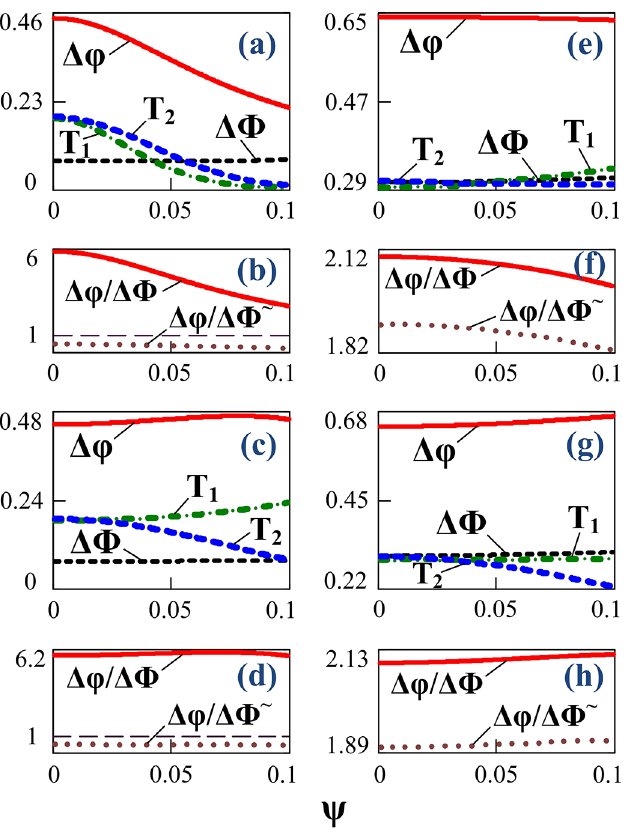
Fig. 8. Dependences of PSD D ’ , DF , relations D ’ / DF , D ’ / DF ∼ and energy transmission coef fi cients T 1,2 of waves 1, 2 on incidence angle c for silver layers 1, 3, two different wavelengths and TM (a, b, e, f), TE (c, d, g, h) polarizations of the incident wave. The values of parameters are: (a – d) l = 292nm, d 1,3 =125 nm, d 2 =19 nm; (e – h) l = 650nm, d 1,3 =9 nm, d 2 = 171nm. Figures b, d, f, h detail the data in fi gures a, c, e, g, respectively. The black horizontal dashed line in fi gures b, d characterizes equality to 1 of the corresponding quantities. Parameter c is used as the abscissa axis for all the graphs. Values of c (as D ’ , DF , DF ∼ ) are given in the relative units of radians / p .